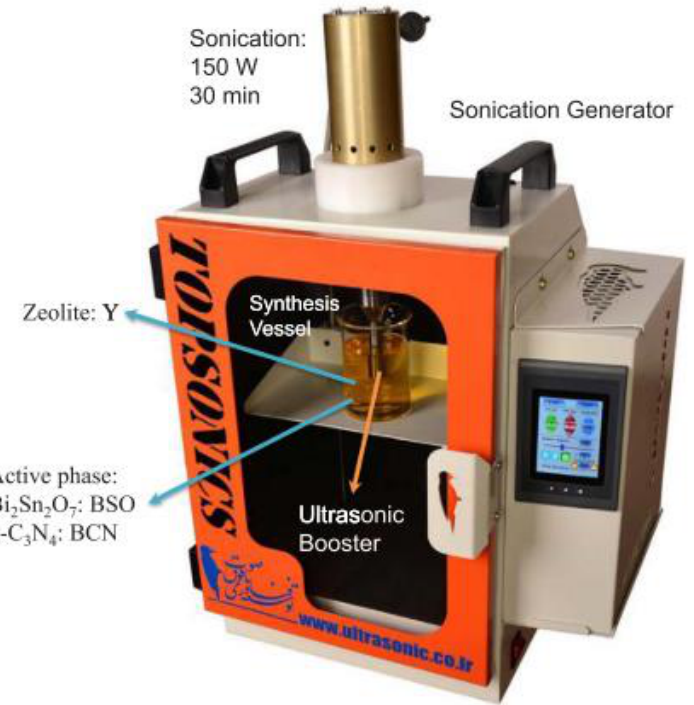
Figure 16. Experimental setup for the sono-dispersion of bulk Bi 2 Sn 2 O 7 and g-C 3 N 4 over zeolite Y. Reprinted with permission from [50].